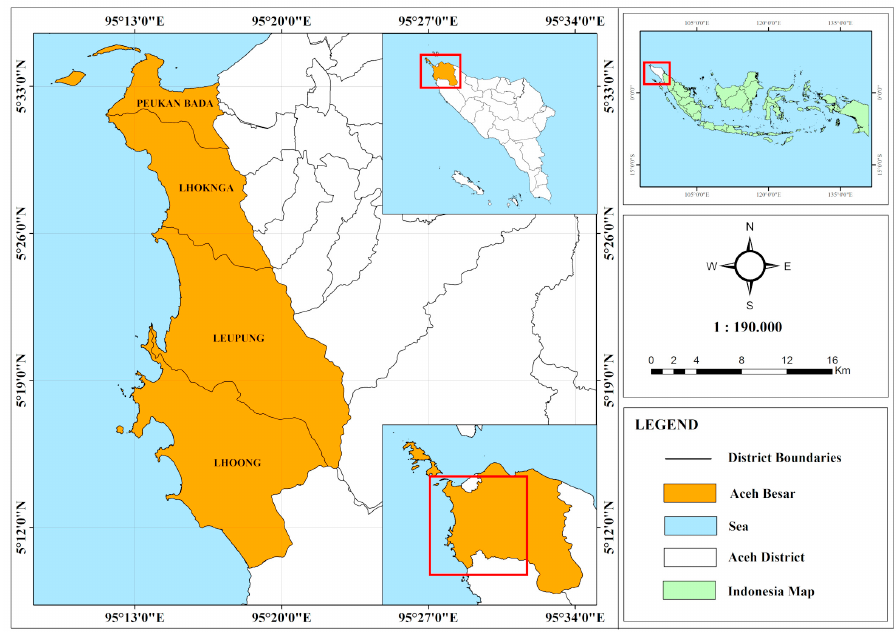
Figure 1. Map of research location in western part of Aceh Besar, district of Aceh, Sumatra, Indone-